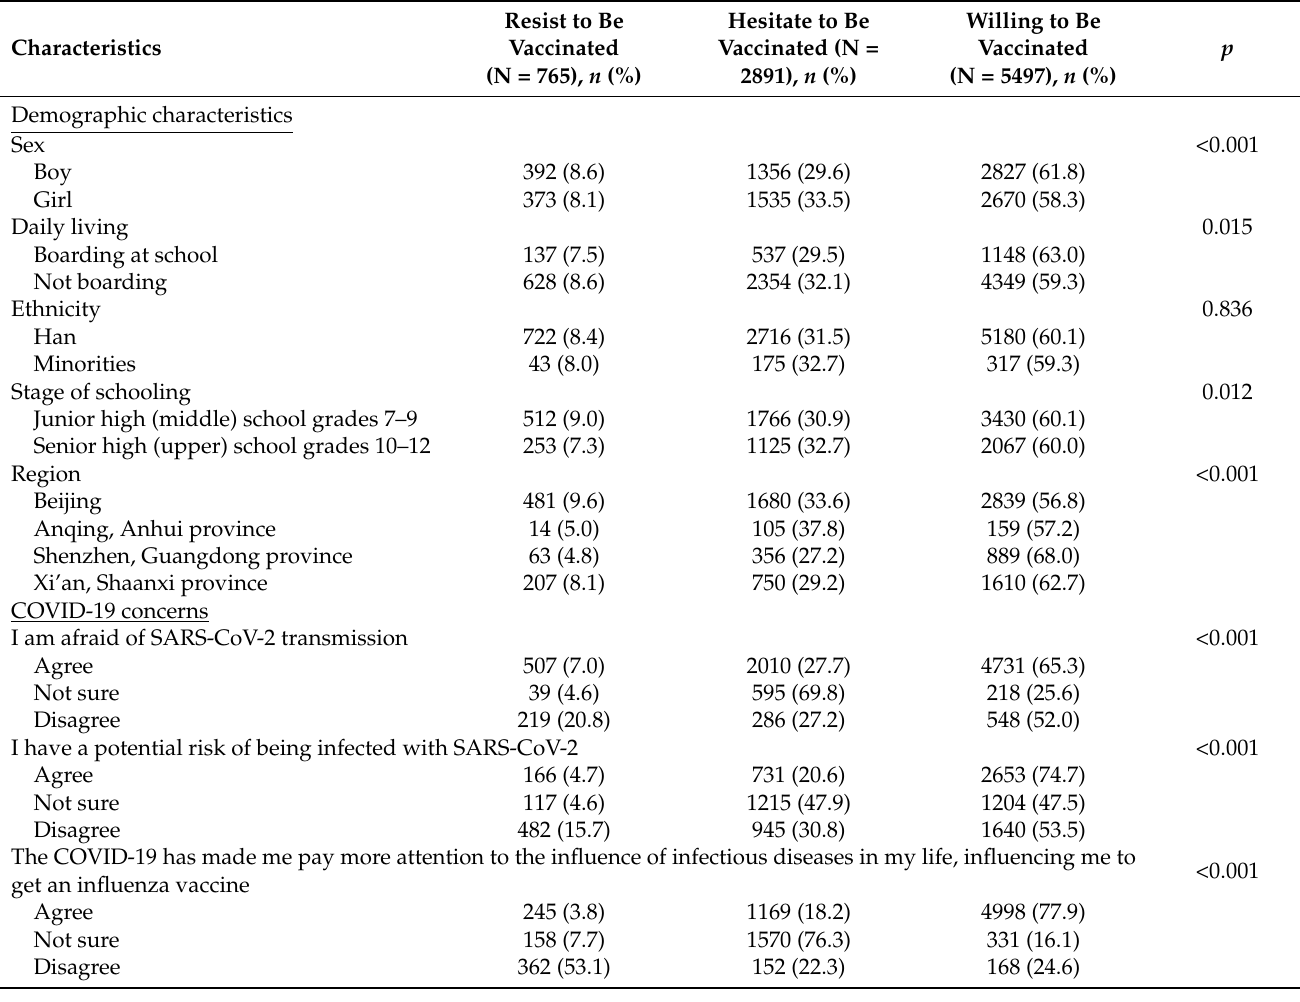
Table 2. Demographic characteristics and COVID-19 vaccination concerns of school students in grades 7–12 in four cities in China, by willingness to getting the vaccine (N =